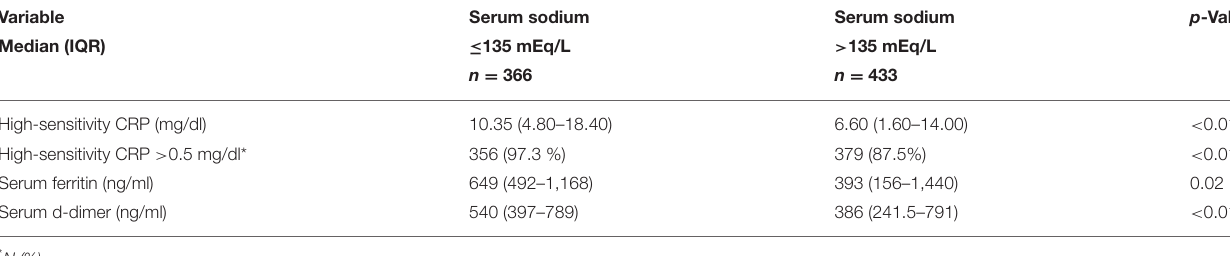
TABLE 2 | Inflammatory parameters in hospitalized patients with COVID-19 with and without hyponatremia on admission. Variable